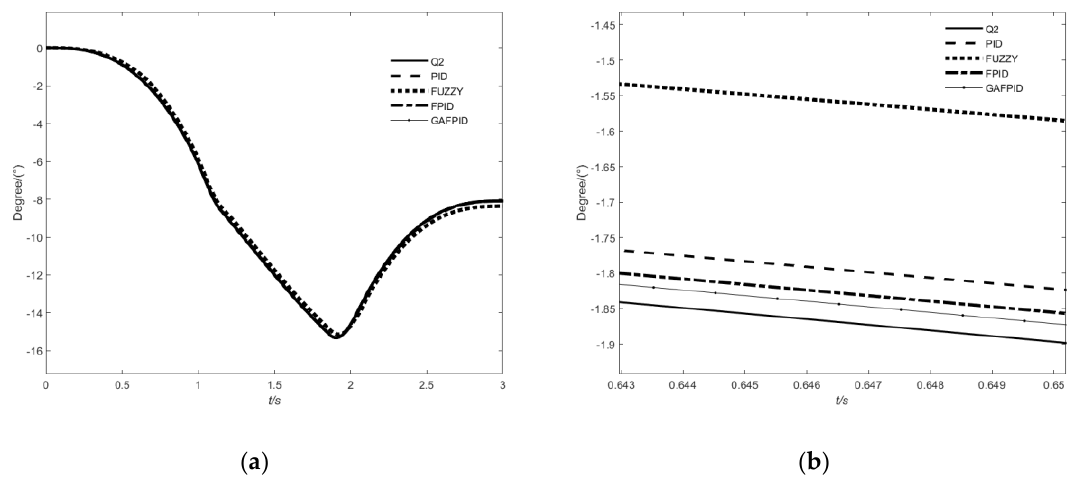
Figure 13. Joint trajectory Q2: ( a ) tracking response; ( b ) local enlarged view.